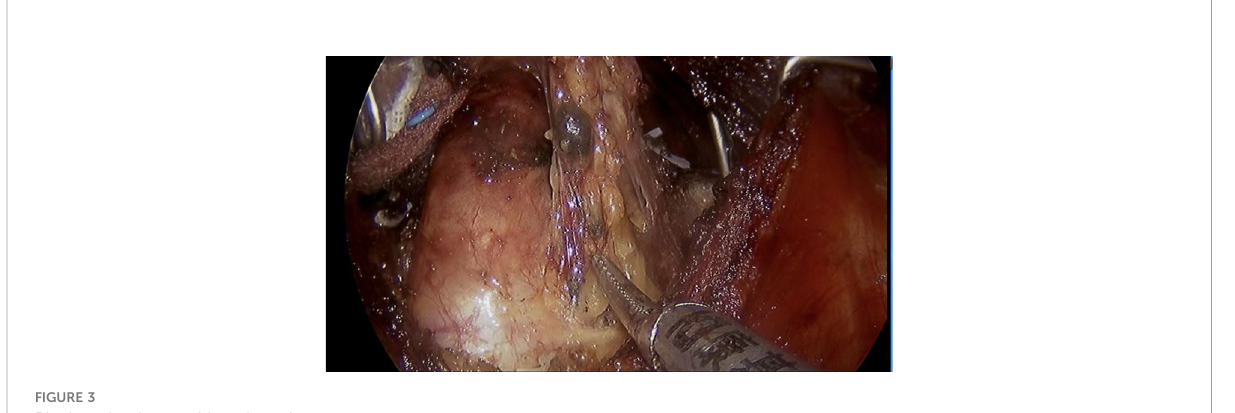
FIGURE 3 Black-stained central lymph